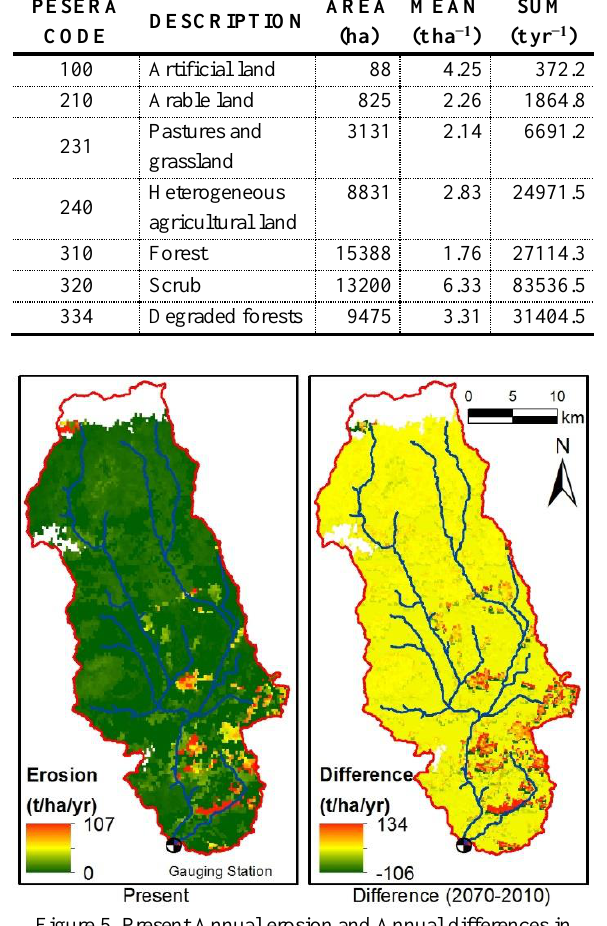
Figure 5. Present Annual erosion and Annual differences in present and future estimated erosion for Egribuk Subcatchment Annual erosion changes were investigated for all seven land cover types described in Figure 6. The largest annual decrease in erosion over time (22,562 t yr -1 ) occurred in forests. Arable land